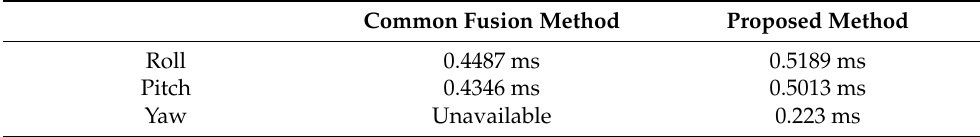
Table 6. Comparison of time required for data processing